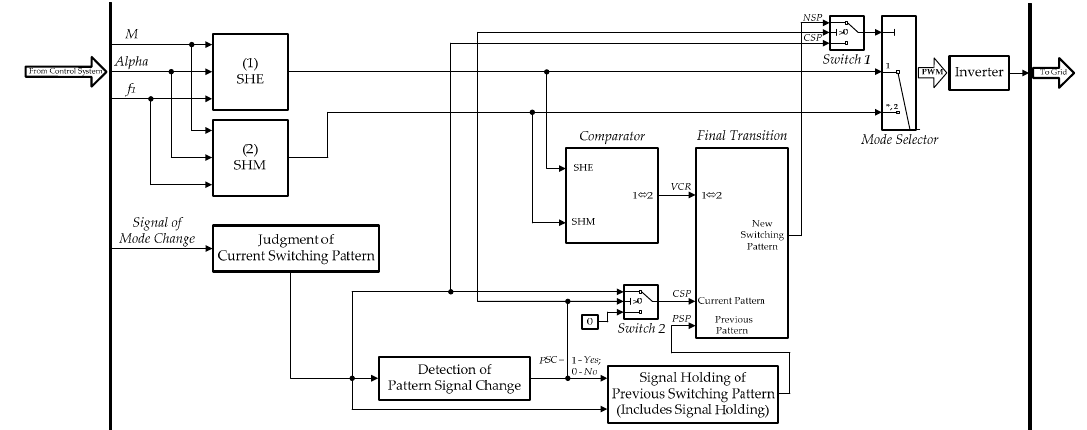
Figure 3. Control block diagram of HPWM transition algorithm between SHEPWM and SHMPWM for 3L-NPC inverters.